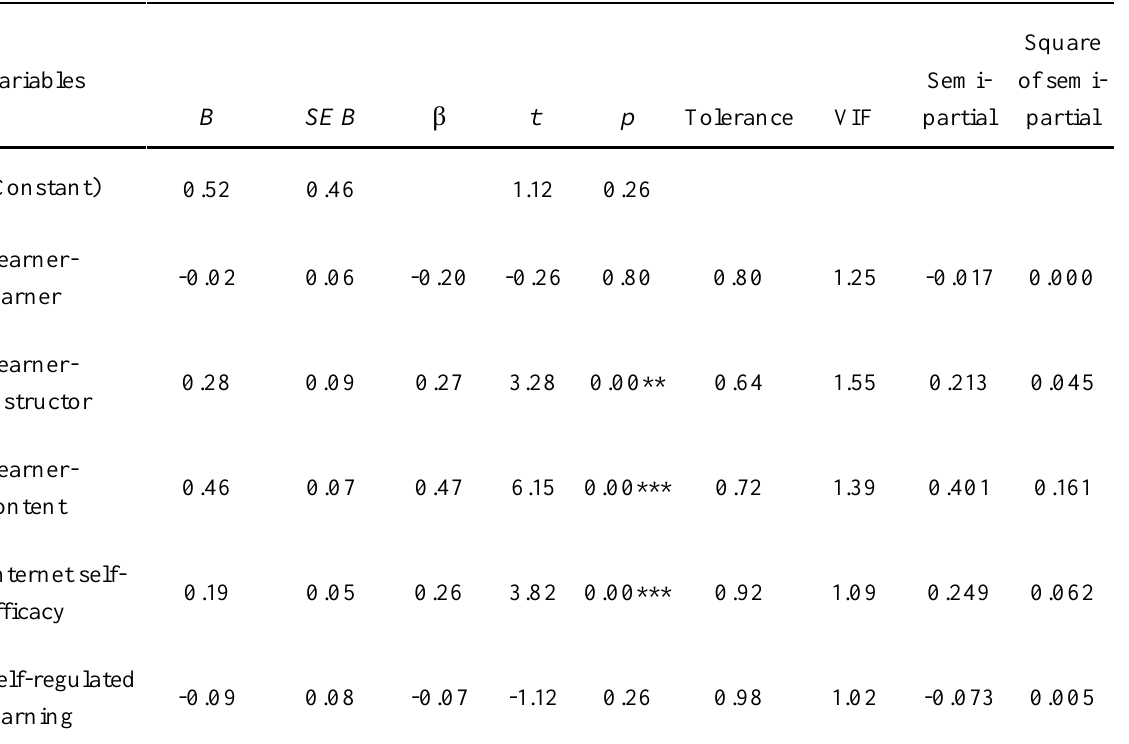
Table 5 Multiple Regression of Five Predictors of Student Satisfaction